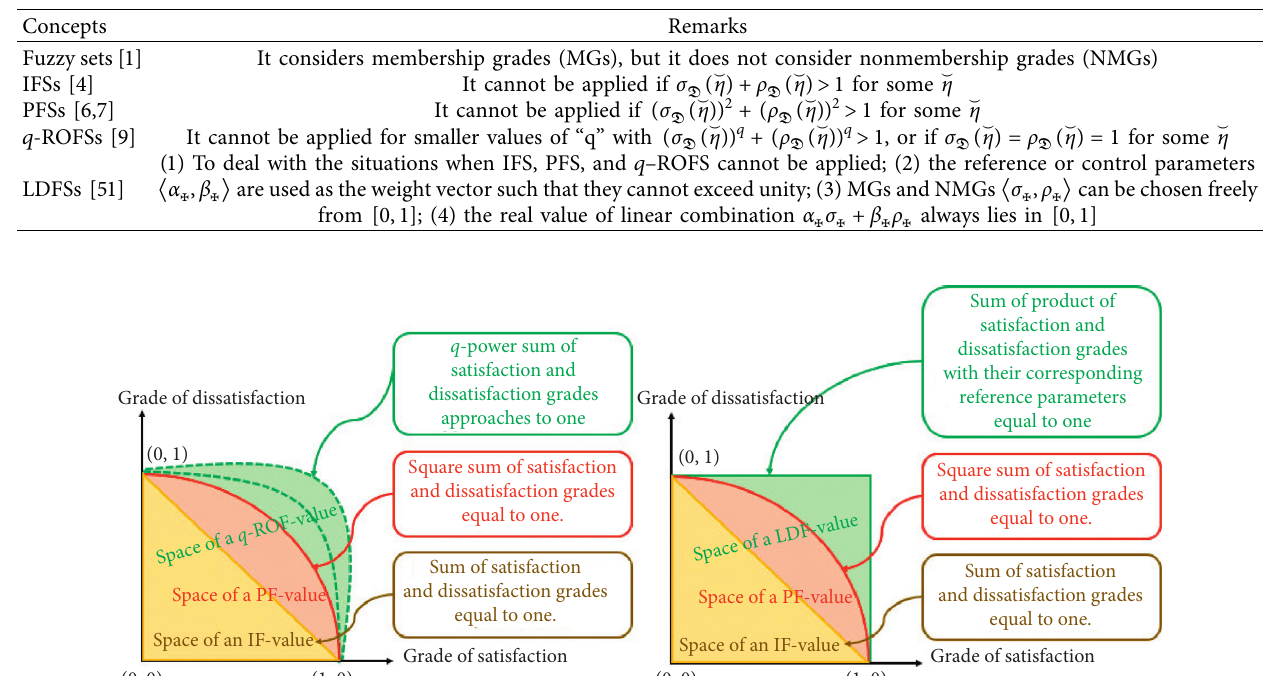
Table 1: Comparison between LDFS with some existing fuzzy sets.